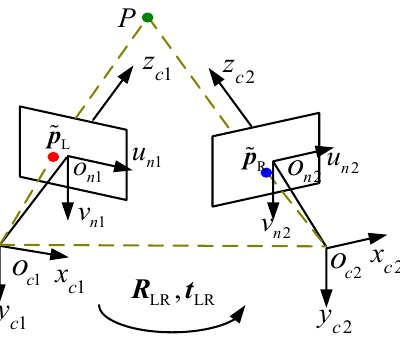
Figure 1. Binocular stereo vision model.